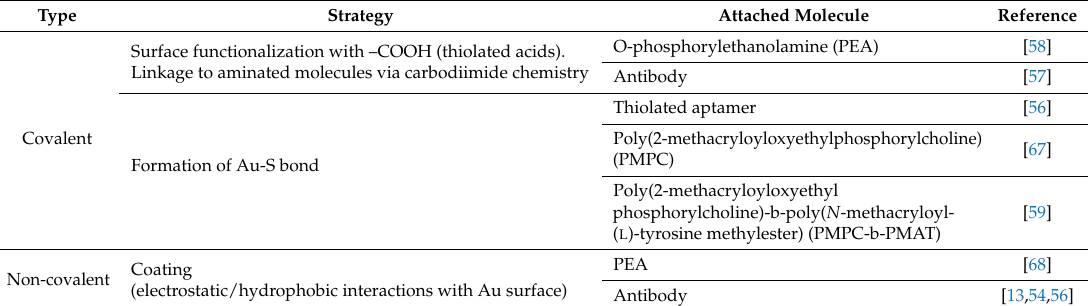
Figure 3. Chemical structure of PEA ( a ) and 2-methacryloyloxyethyl phosphorylcholine (MPC) containing PC functionality ( b ) (PC group represented in blue). Table 1. Strategies for surface modification and bioconjugation of gold nanoparticles (Au NPs) aiming for specificity towards C-reactive protein